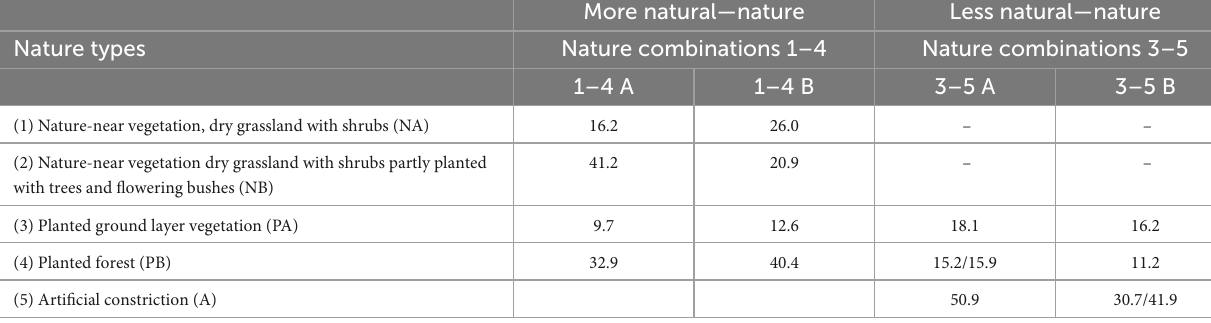
*Correlationissignificantatthe0.05level. **Correlationissignificantatthe0.01level. TABLE 6 Preferred types of nature in different nature combinations by participants (in percent).